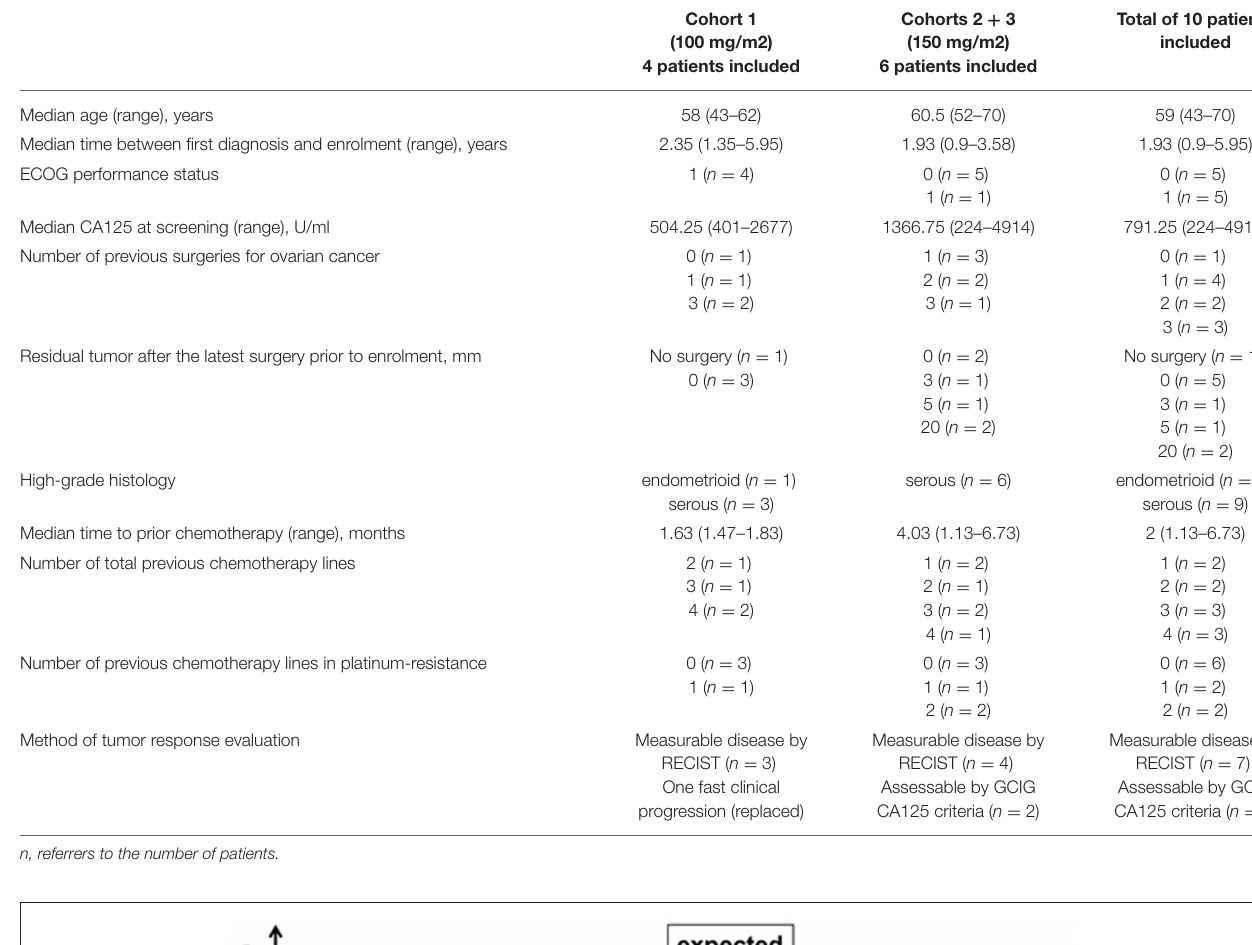
TABLE 2 | Baseline characteristics of patients included into the Phase I GANNET53